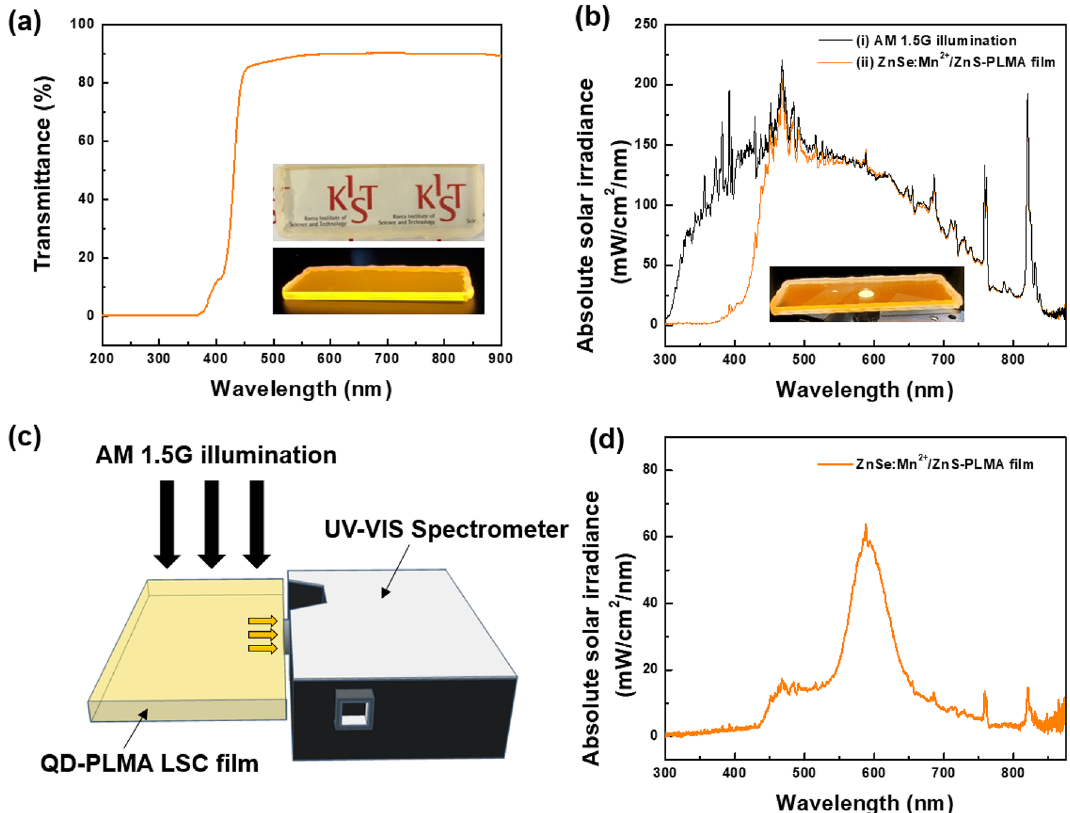
Figure 5. ( a ) Transmittance spectrum of ZnSe:Mn 2+ /ZnS-PLMA film. Inset shows photographs of the fabricated ZnSe:Mn 2+ /ZnS-PLMA film under indoor room light (top) and UV light (λ ex = 365 nm) (bottom). ( b ) Irradiance spectra of (i) AM 1.5G light from a solar simulator and (ii) AM 1.5G light passing through the ZnSe:Mn 2+ /ZnS-PLMA film under AM 1.5G illumination from a solar simulator. Inset shows a photograph of the fabricated ZnSe:Mn 2+ /ZnS-PLMA film under AM 1.5G illumination. ( c ) Schematic illustration showing the measurement of the edge emission from the ZnSe:Mn 2+ /ZnS-PLMA LSC film. (d) Luminescence spectrum of the emission from the long edge of the ZnSe:Mn 2+ /ZnS-PLMA film under AM 1.5G edge of the ZnSe:Mn 2+ /ZnS-PLMA film. The weak emission band due to the scattered light was also observed at the edge of the bare PLMA film without QDs when the bare PLMA film without QDs was illuminated with AM 1.5G white light from the solar simulator (Fig. S7). To investigate the self-absorption loss of the ZnSe:Mn 2+ /ZnS-PLMA LSC film, optical path dependent edge PL spectra were obtained, as depicted in Fig. 6a. When the 442 nm light was used as an excitation source, apparent PL bands due to the 4 T 1 → 6 A 1 transition of Mn 2+ ions were observed (Fig. 6b). Although PL intensity decreased with increasing distance between the edge of the LSC film and the position of the excitation light, it was saturated to 77.0% of the initial PL intensity and no further PL decrease was observed. For a control experiment, a CdSe/ ZnS QD-PLMA LSC film was fabricated using commercial CdSe/ZnS QDs (Lumidot™, purchased from Sigma- Aldrich) since CdSe/ZnS QDs are representative QDs with high efficiency but small Stokes shift (Figs. S8 and S9). As shown in Fig. 6c, the PL intensity of the CdSe/ZnS-PLMA LSC film largely decreased when the distance between the edge of the LSC film and the position of the excitation light was increased. Notably, the PL intensity of the CdSe/ZnS-PLMA film rapidly decays due to the significant self-absorption loss, decreasing to about 36.3% of the initial PL intensity at d = 55 mm. Figure 6d exhibits normalized integrated PL intensities of the ZnSe:Mn 2+ / ZnS-PLMA and CdSe/ZnS-PLMA LSC films, and it shows that the optical path-dependent PL loss of the CdSe/ ZnS-PLMA LSC film was much larger than that of the ZnSe:Mn 2+ /ZnS-PLMA LSC film. Importantly, no shift in PL band was observed for the ZnSe:Mn 2+ /ZnS-PLMA LSC film, regardless of the excitation position (Fig. 6e), while the CdSe/ZnS-PLMA LSC film showed significant redshift of the PL band depending on the excitation position (Fig. 6f). These results prove that there was no reabsorption in the ZnSe:Mn 2+ /ZnS-PLMA LSC film due to a large Stokes shift in the ZnSe:Mn 2+ /ZnS QDs. In contrast, while the light emitted from the CdSe/ZnS QDs propagated in the LSC film, the PL band largely shifted to a longer wavelength due to self-reabsorption by CdSe/ ZnS QDs. Consequently, the optical path-dependent PL results of the QD-PLMA films confirm the advantage of ZnSe:Mn 2+ /ZnS QDs with large Stokes shift for LSC applications.